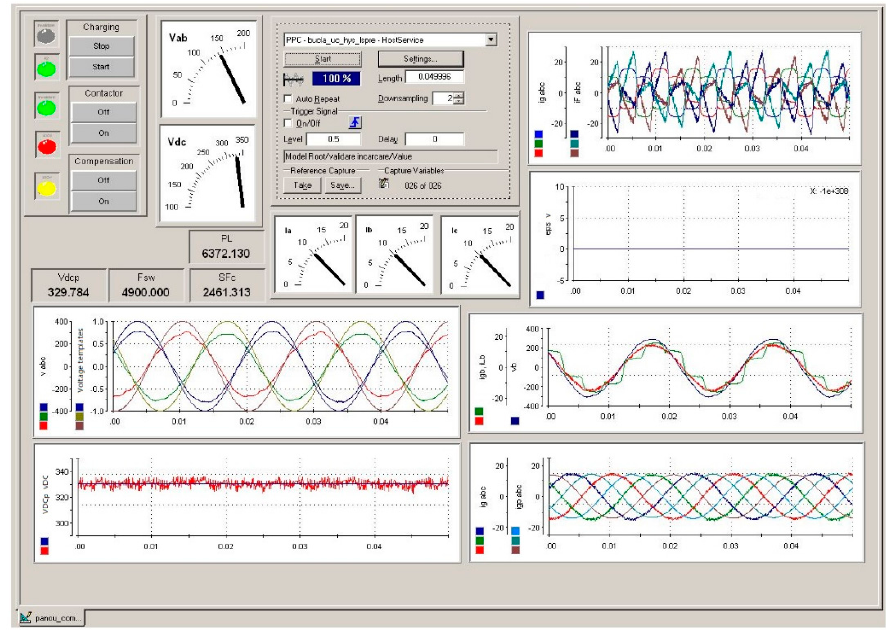
Figure 18. The real-time control desk interface.